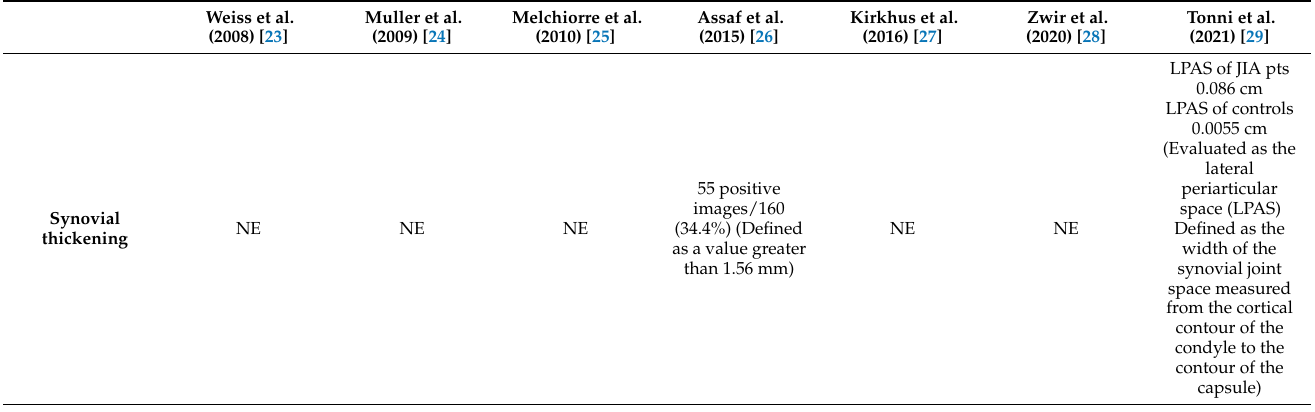
The Spearman test applied to the values of LPAS measured in ultrasound and the corresponding MR